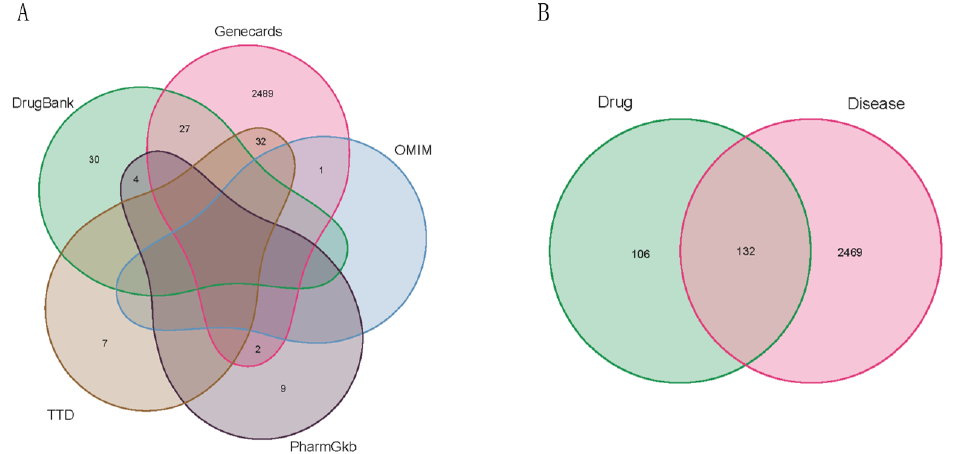
Figure 1. ( A ) Venn diagrams showing UC targets obtained from five databases, ( B ) the intersection of identified target genes of BDMC and UC. identified target genes of BDMC and